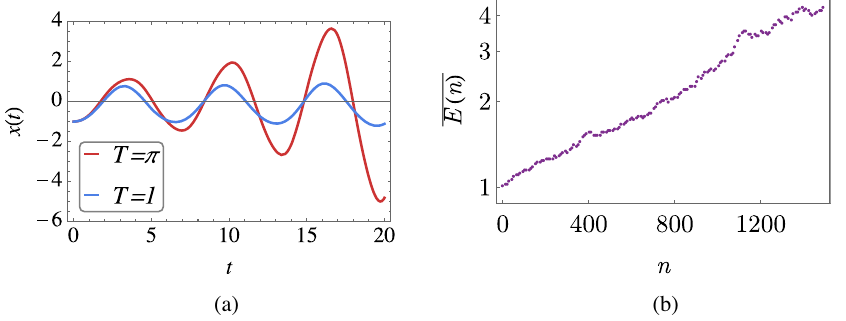
FIG. 18. Dynamics of a Mathieu oscillator without and with random driving. (a) Mathieu oscillator under a weak driving force is stable for T < 1 and unstable for T ¼ π . We choose h ¼ 0 . 2 . (b) For random driving, the energy grows exponentially even for small